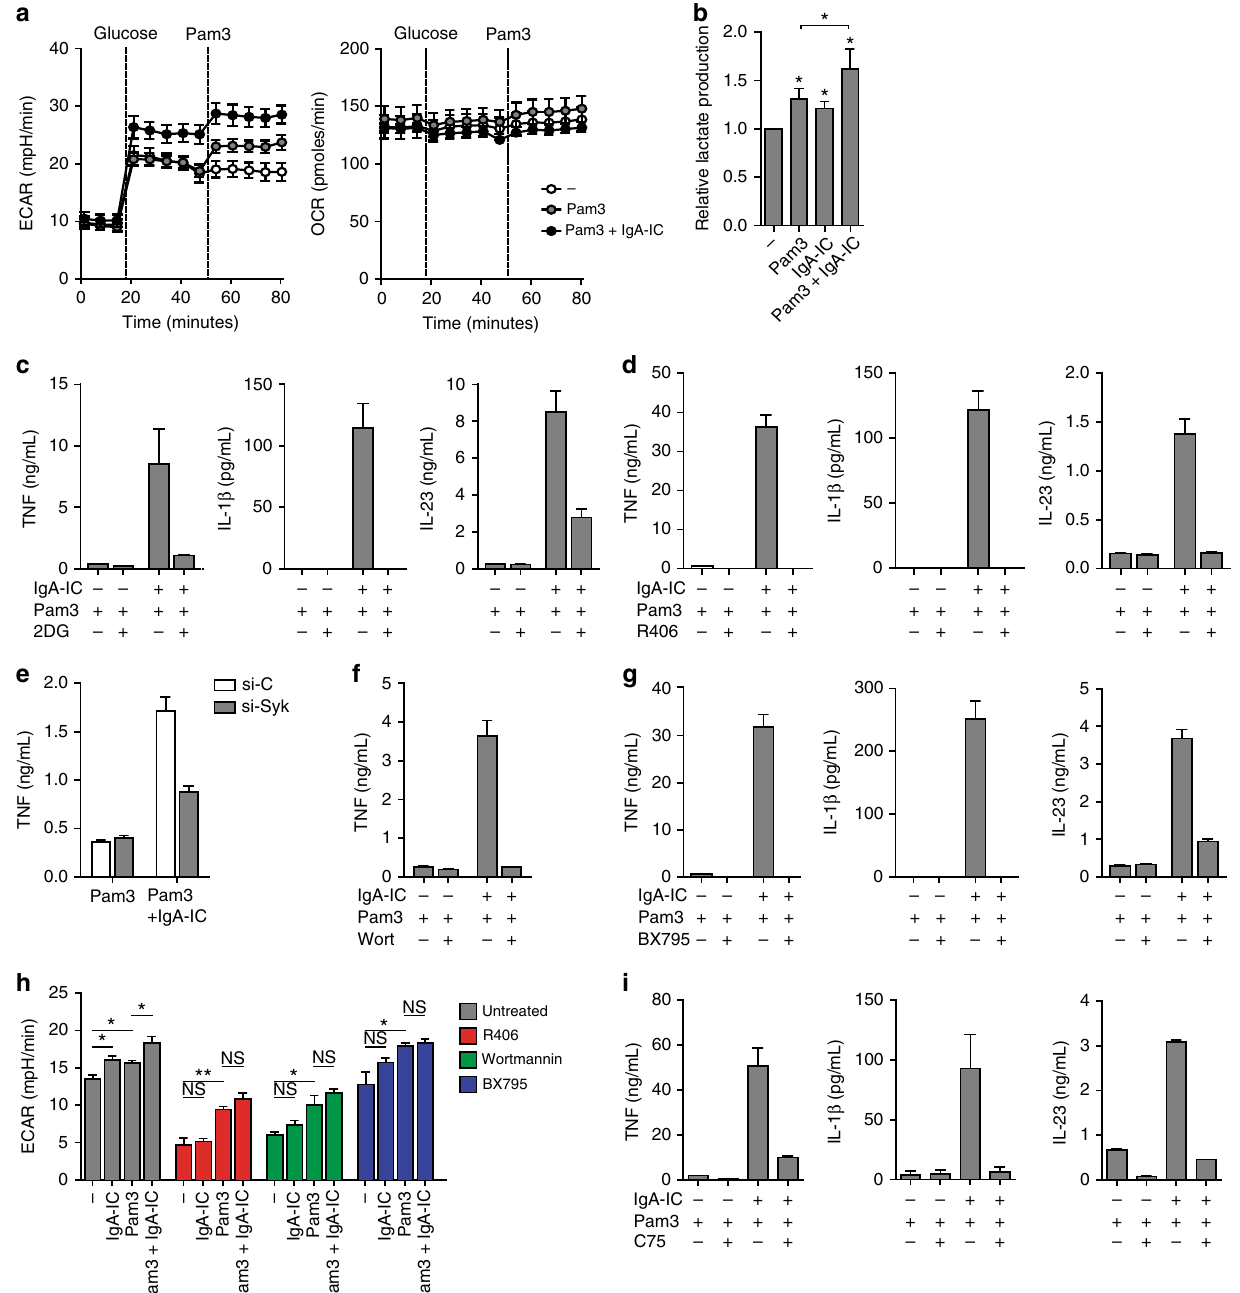
Fig. 6 Fc α RI-induced upregulation of cytokine production is dependent on glycolytic reprogramming through Syk, PI3K, and TBK1-IKK ε . a Real-time changes in the extracellular acidi fi cation rate (ECAR) and oxygen consumption rate (OCR) of CD103 + dendritic cells (DC) left unstimulated (open circles), stimulated with Pam3CSK4 (Pam3) alone (grey circles), or Pam3CSK4 with IgA immune complexes (IgA-IC) (black circles). IgA-IC are present from the start of the experiment. The dotted line indicates initiation of further treatment. Experiments were performed in quadruplicate, mean + s.e.m. b Relative lactate production of CD103 + DCs after 24 h of treatment. Pooled data from fi ve experiments. * p < 0.05. Student ’ s t test. c , d Cytokine production by CD103 + DCs stimulated with Pam3CSK4, IgA-IC, or a combination after treatment with 10 mM glycolysis inhibitor 2-deoxy-D-glucose (2DG) ( c ) or 1 µ M of syk inhibitor R406 ( d ). e TNF production by CD103 + DCs silenced using speci fi c si-RNA for Syk (si-Syk) or non-targeted control (si-C). f , g Cytokine production by CD103 + DCs stimulated with Pam3CSK4, IgA-IC, or a combination after treatment with 100 nM PI3K inhibitor Wortmannin (Wort) ( f ) or 1